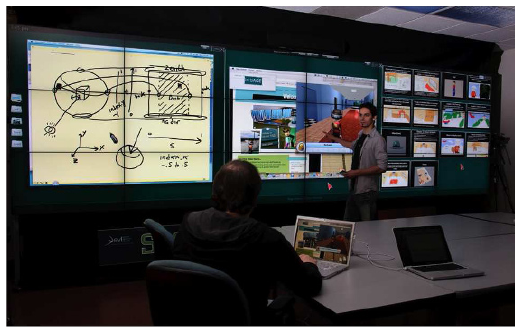
Figure 25. EVL’s CyberCommons and SAGE. Photo: Lance